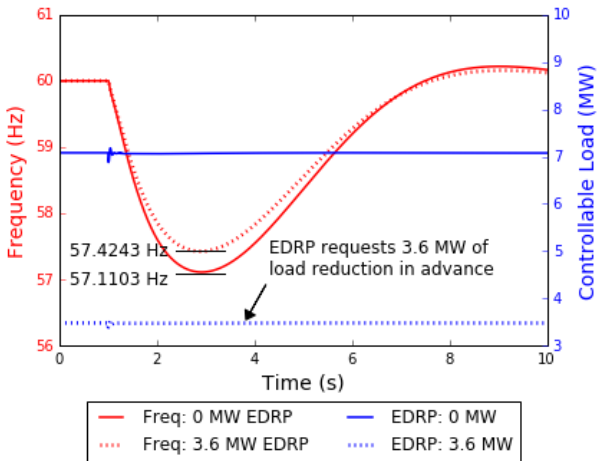
Figure 8. The N -1 contingency simulation with / without EDRP load Figure 8. The N-1 contingency simulation with/without EDRP load reduction. Table 3. The frequency support capability of EDRP–case study.